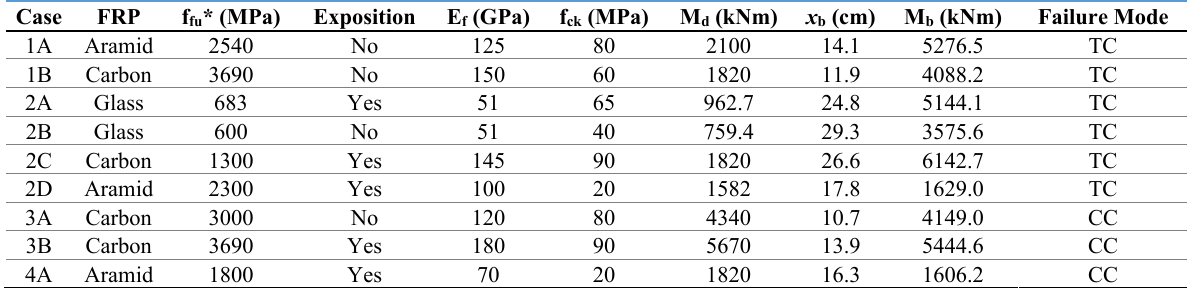
Table 2. Definition of the failure mode corresponding to all design approaches previously